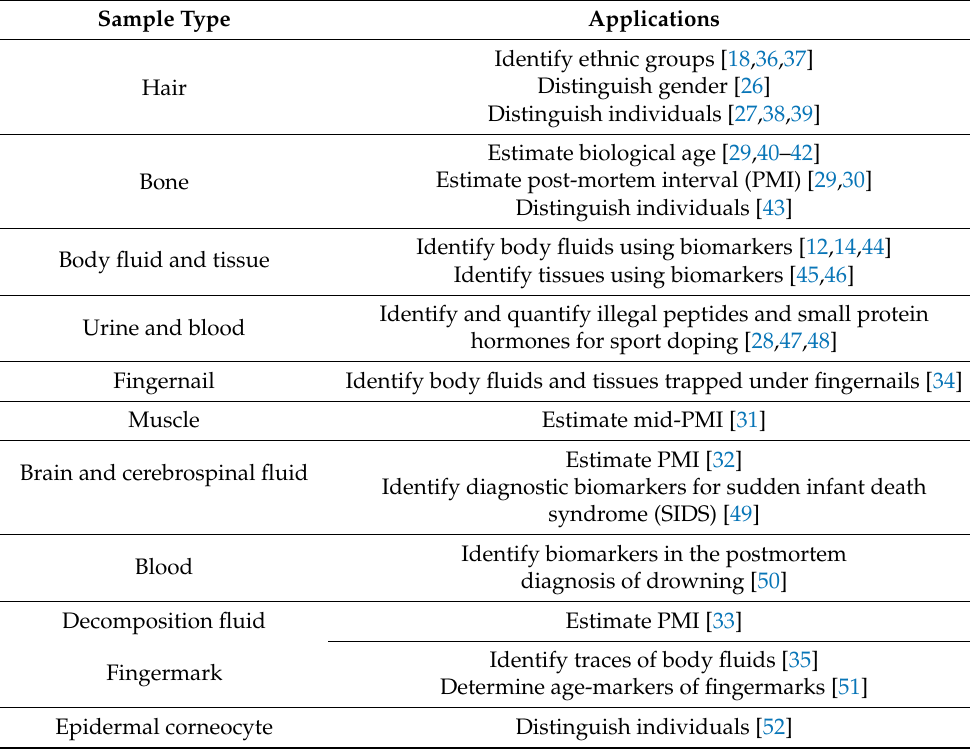
Table 1. Applications of forensic proteomics using human